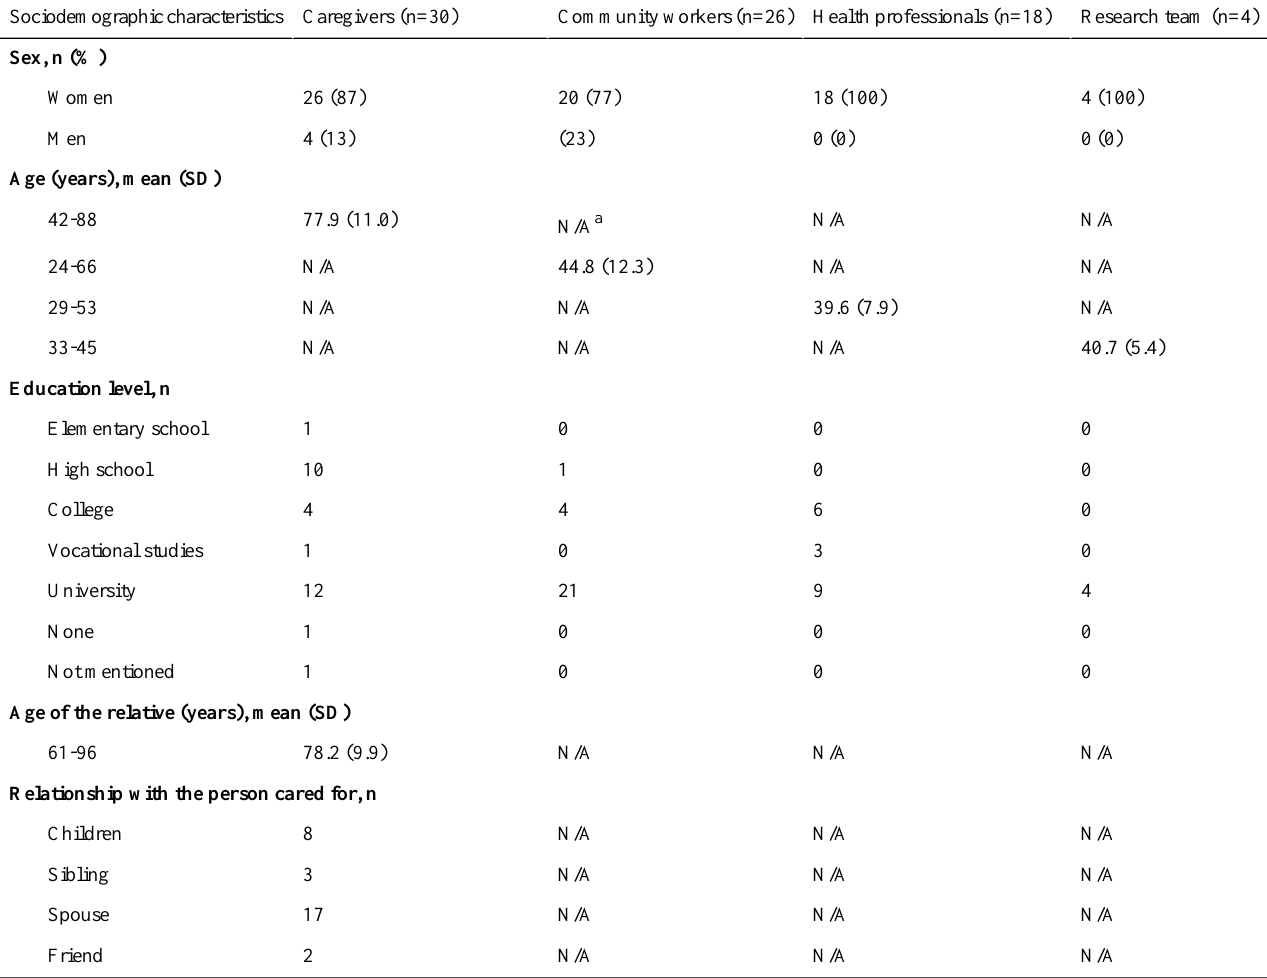
Table 2. Description of